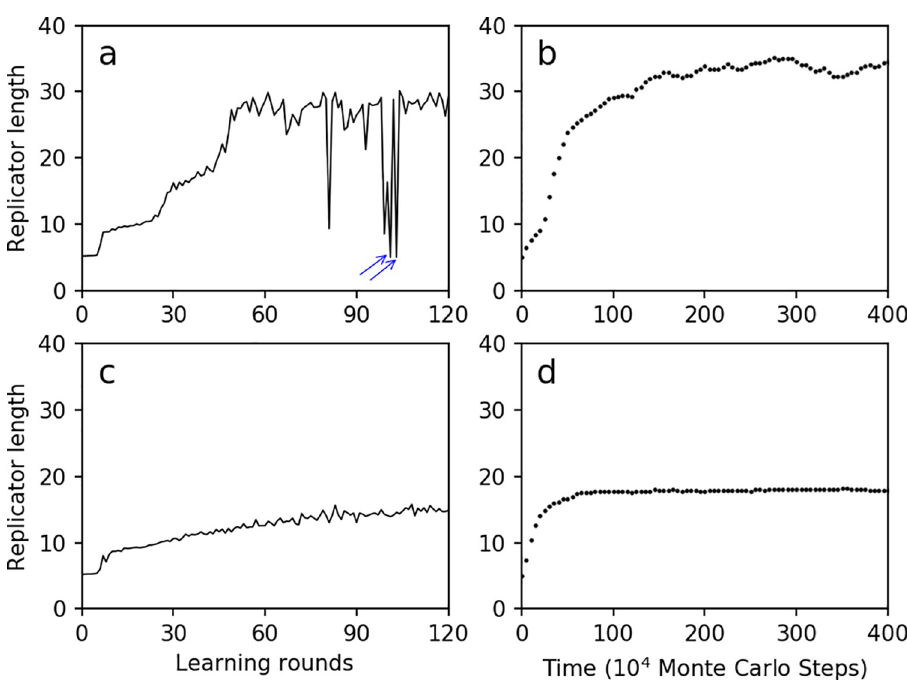
Fig 8. The average length of replicators improves via parameter-exploration in principle of machine-learning. ( a ) The objective function is the average length of replicators at step 100 × 10 4 , with a starting point of learning which was assumed in case Fig 7B. The arrows indicate “odd points”, which denote the rounds when the total number of replicators is zero and the average length of replicators is assumed ( ad hoc ) to adopt the starting value, i.e. 5. ( b ) The improved evolutionary dynamics (in reference of that in Fig 7B) by adopting the learned parameter set at the 60th learning round in a : α A = 0.0727, β A = 2.57, γ A = 393, α B = 0.0766, β B = 4.42, γ B = 169, β C = 1.88, γ C = 3.35. ( c ) The objective function is the average length of replicators at step 20 × 10 4 , with a starting point of learning assumed in case Fig 7B. ( d ) The improved evolutionary dynamics (in reference of that in Fig 7B) by adopting the parameter set at the 80th learning round in c : α A = 0.0358, β A = 2.97, γ A = 452, α B = 0.251, β B = 1.44, γ B = 143, β C = 2.22, γ C = 1.23.